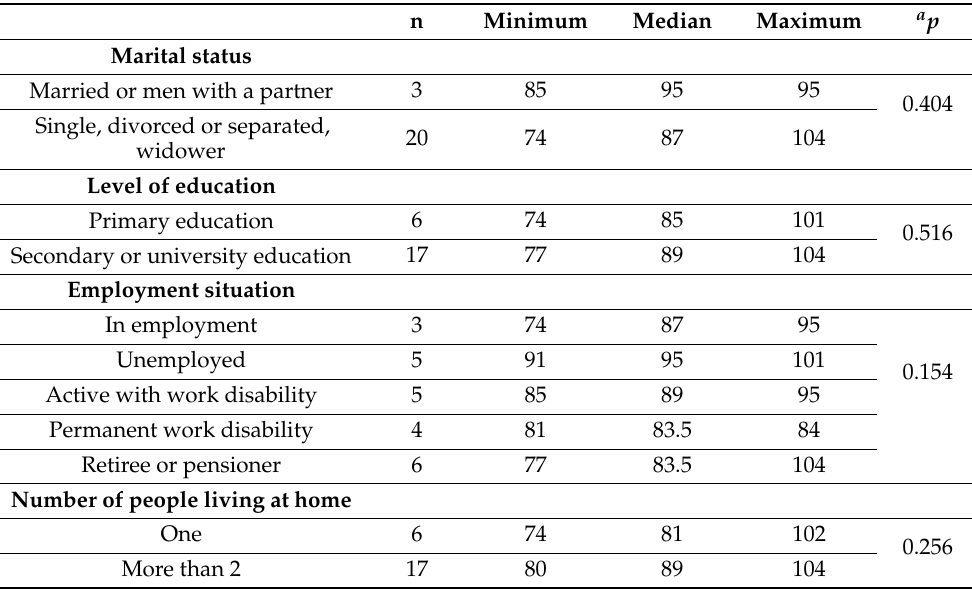
Table 5. Total FIQ values according to sociodemographic